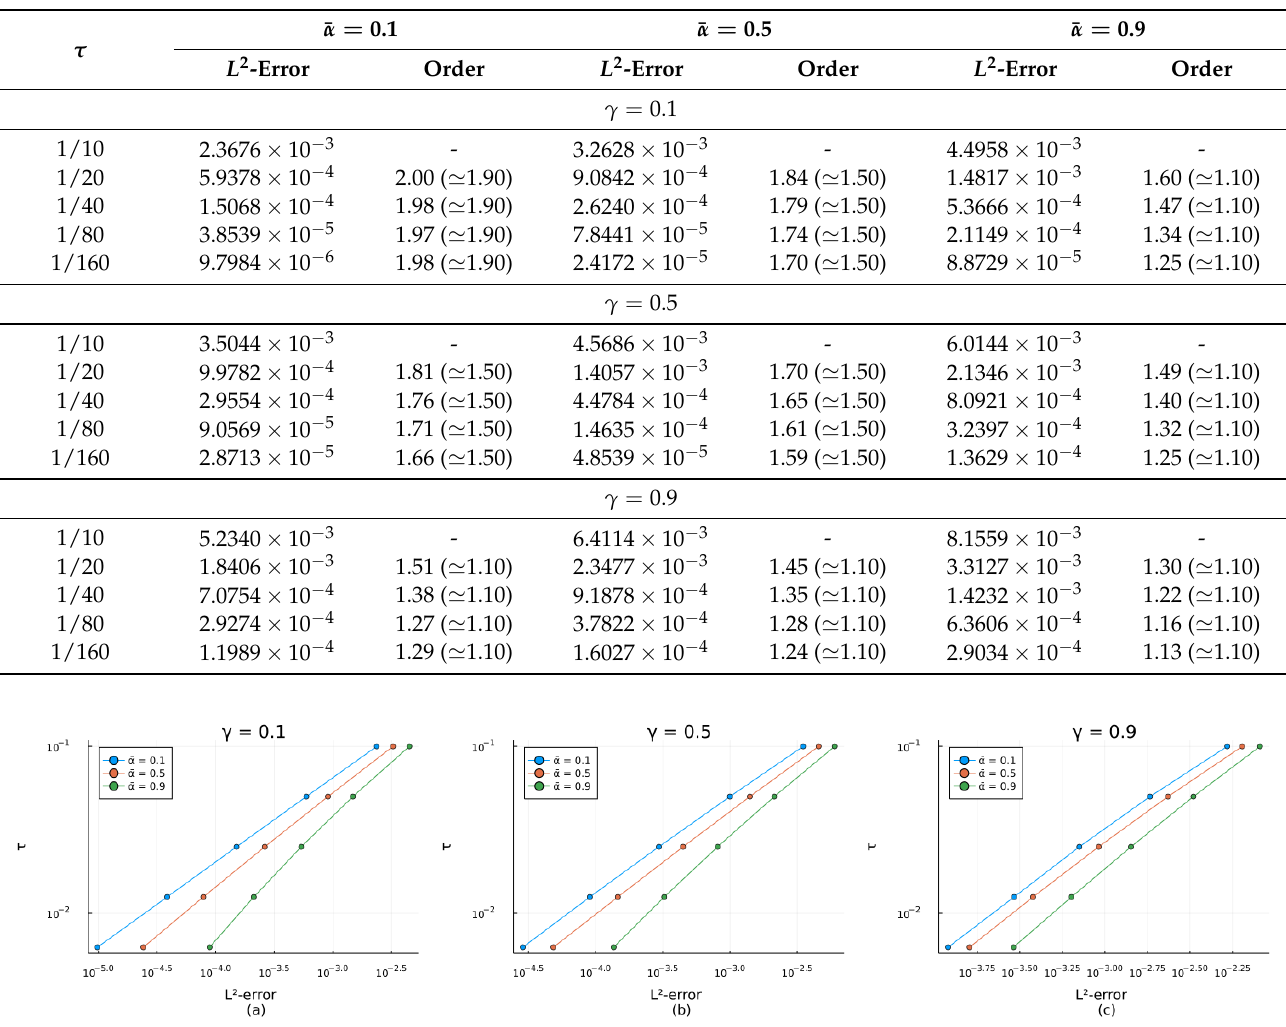
Figure 3. Error plots with respect to the time step τ obtained for Example 2 with h = 1/40,000 and different orders of fractional derivatives: ¯ α ∈ { 0.1,0.5,0.9 } ; ( a ) γ = 0.1. ( b ) γ = 0.5. ( c ) γ =